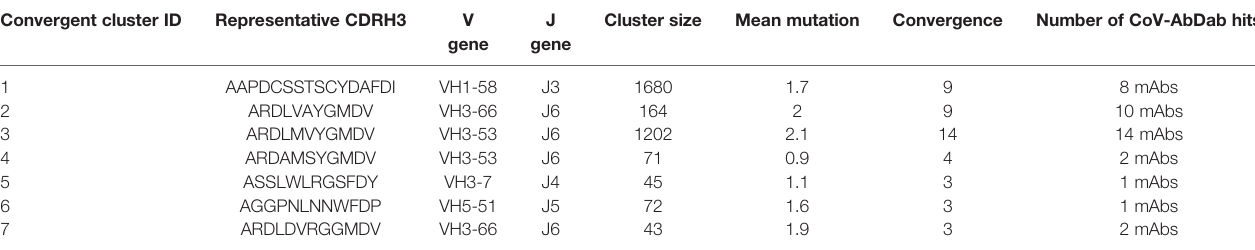
Table3A showsthepropertiesofconvergentantibodyclustersidenti fi edfromthecurrentstudy,includingthesizeofthecluster(i.e.,uniqueantibodiesfoundineachcluster,anindicatorof clonal expansion), number of different patients each cluster was present in (convergence) and number of antibodies found in the CoV-AbDab database with the same cluster identity.